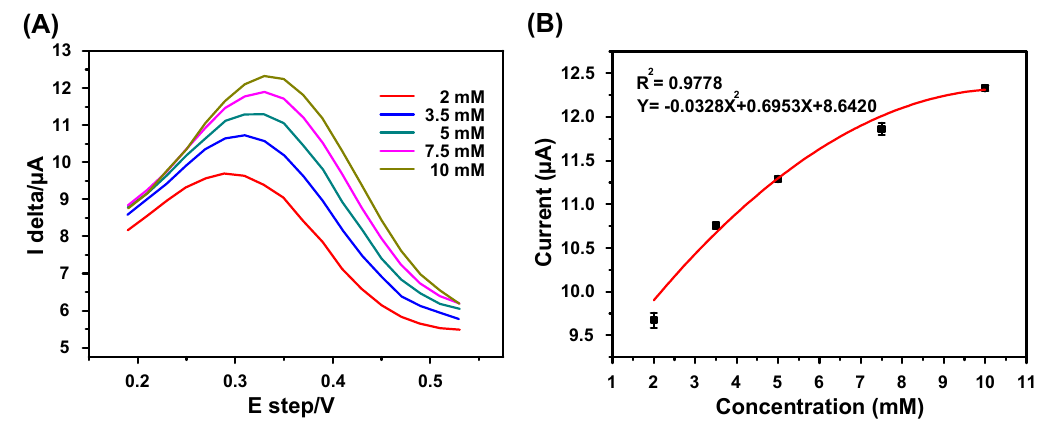
Figure 7. SWV detection results of K + with various concentrations: ( A ) cyclic voltammograms (100 mV/s) for various K + concentrations (2–10 mM); ( B ) quadratic calibration curve representing the relation between the stable oxidization peak current and concentration; scanning range: 0.2–0.6 V, pulse height 100 mV, pulse width 200 ms, step height 20 mV, N = 3.